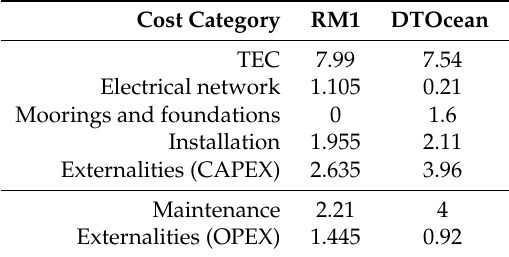
10 − 2 (cid:100) /kWh where 1 $ ×